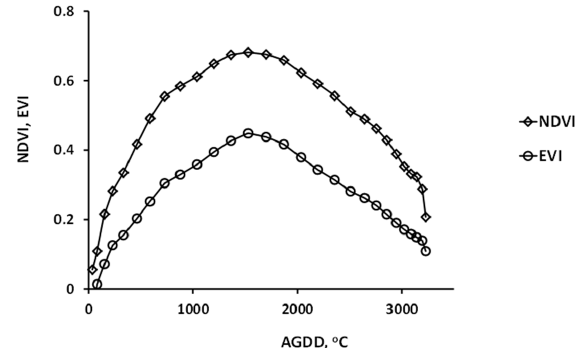
Figure 8. Average MODIS NDVI and EVI as a function of AMSR-E AGDD for Petropavlovsk 3,